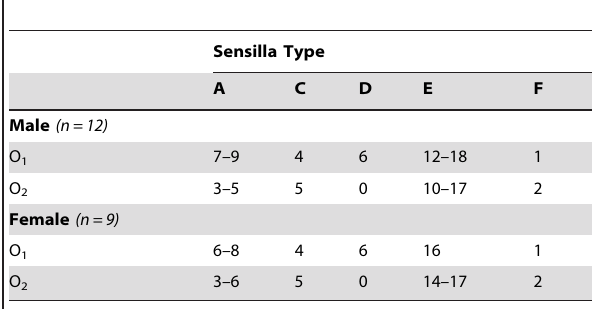
Table 1. Number of sensilla in male and female C. hemipterus